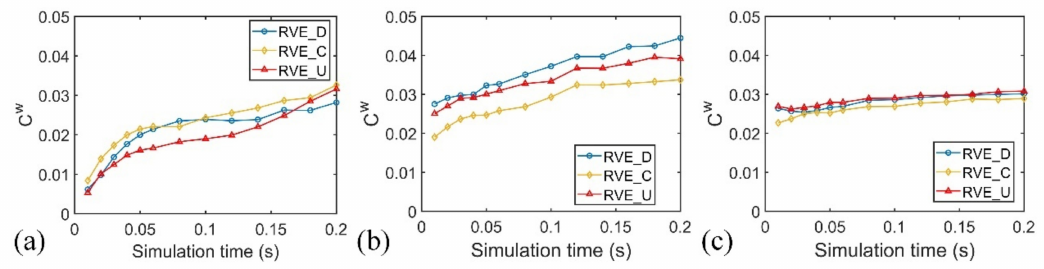
Figure 12. Evolution of C w for the specimen ( a ) FC30; ( b ) FC40; and ( c )